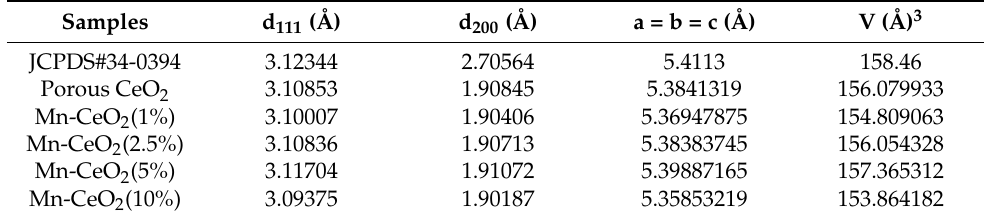
Table 2. Lattice constants were obtained theoretically for all Mn-CeO 2 samples.